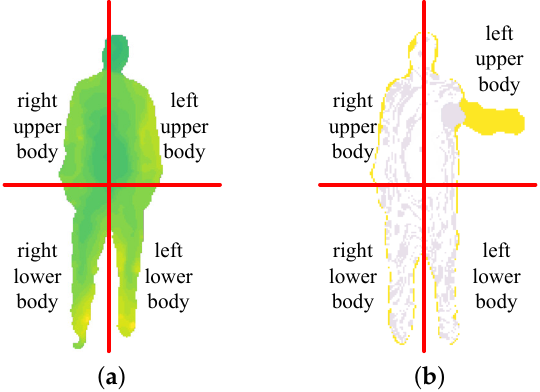
Figure 6. The division of human activity areas. ( a ) The division of human activity areas at the beginning of the action; ( b ) The division of human activity areas when the